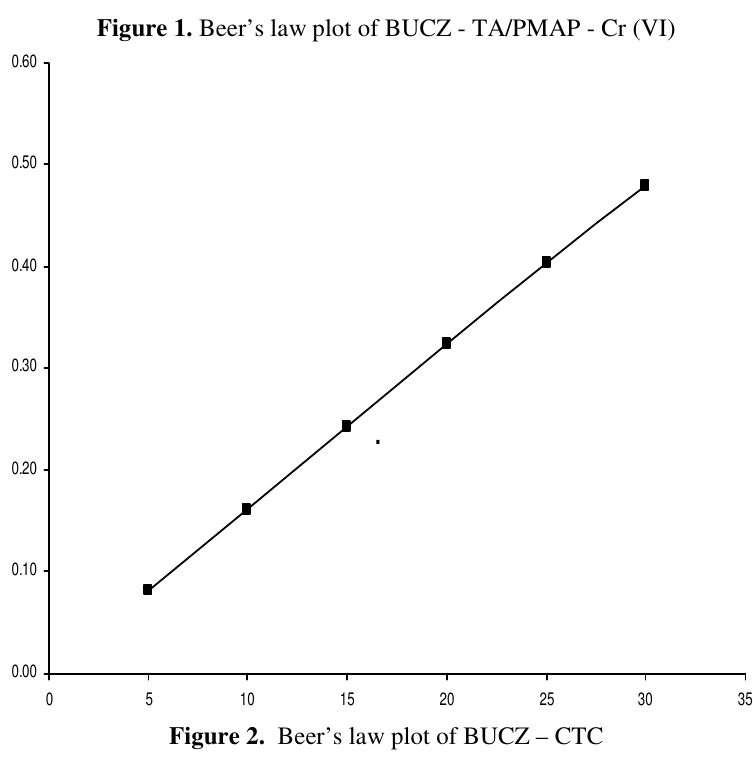
Figure 2. Beer’s law plot of BUCZ –